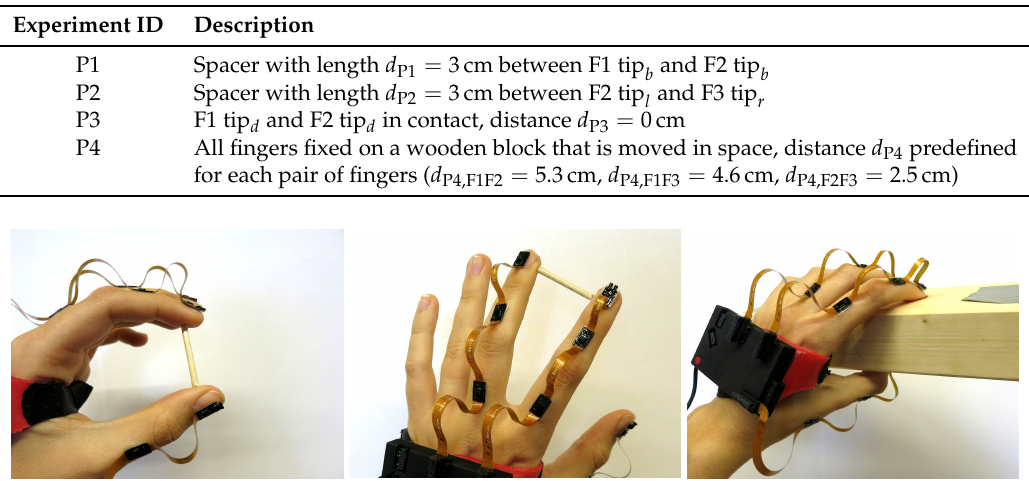
Table 5. Overview of experiments in Setting 2 with predefined postures in a magnetically disturbed environment.